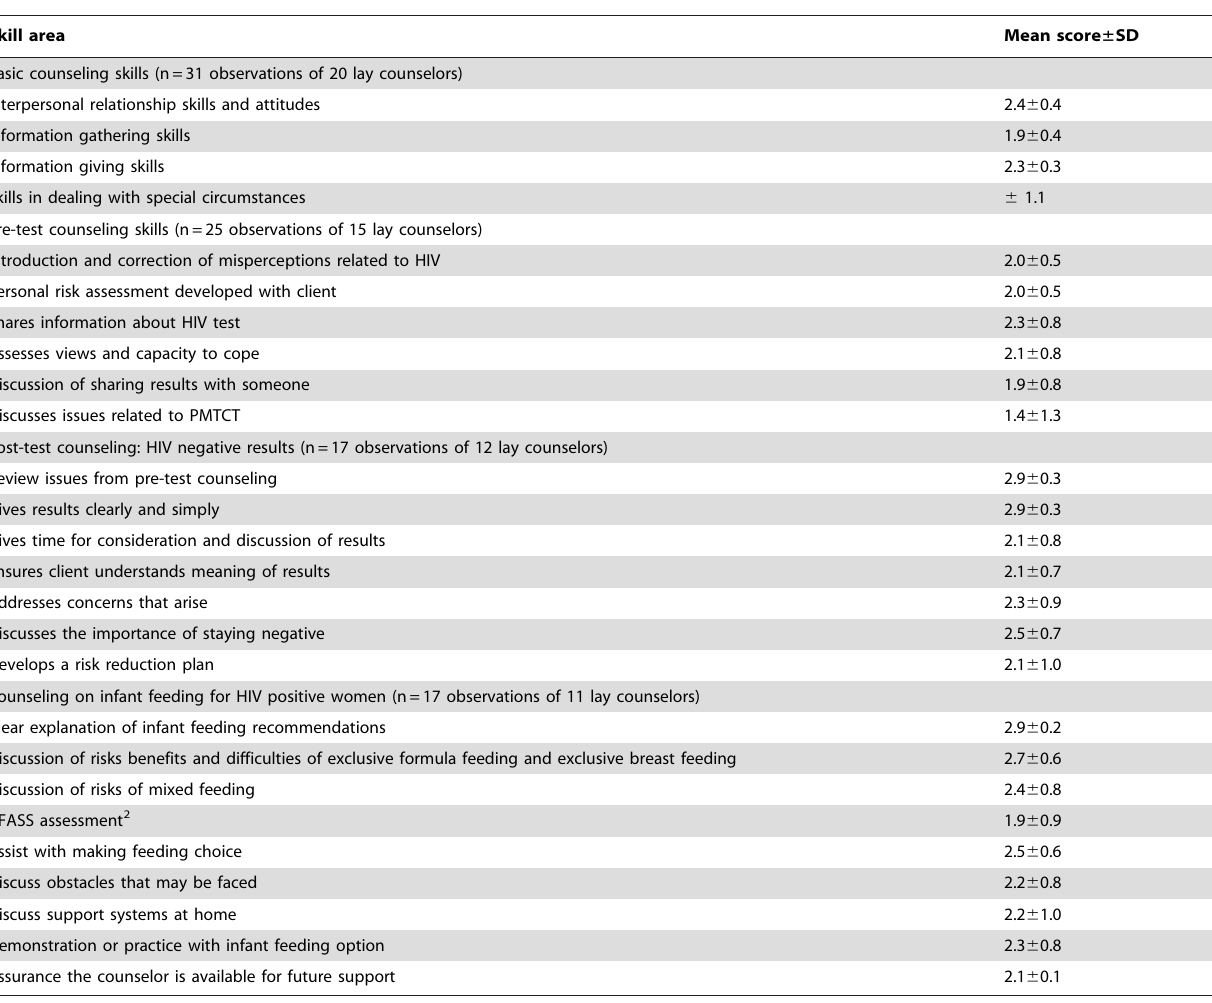
Table 3. Mean scores from observation sessions conducted with 25 lay counselors.